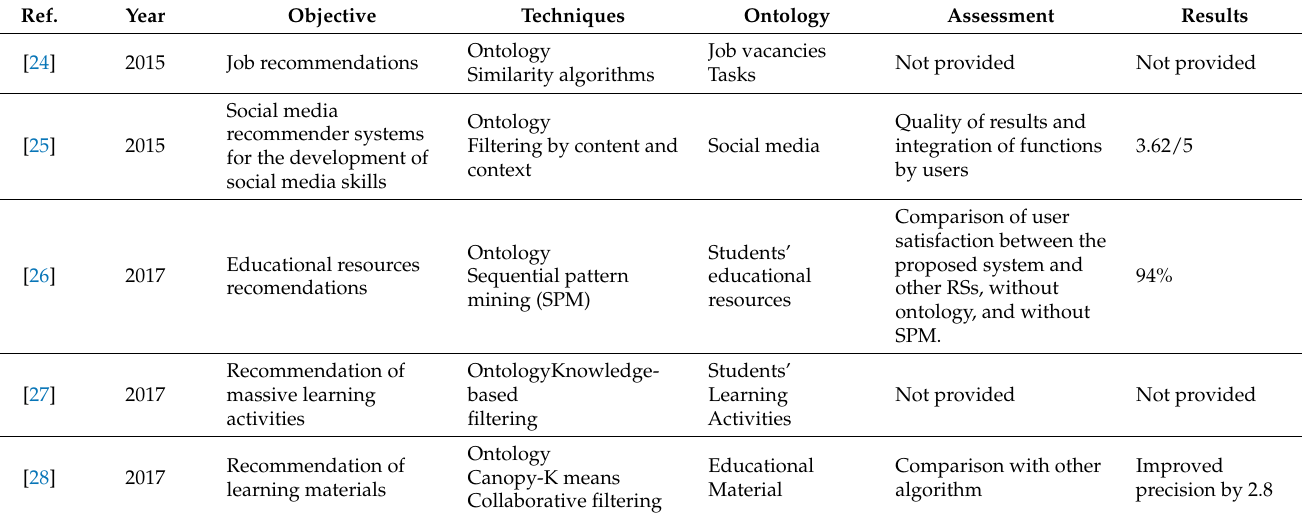
Table 1. RSs that use